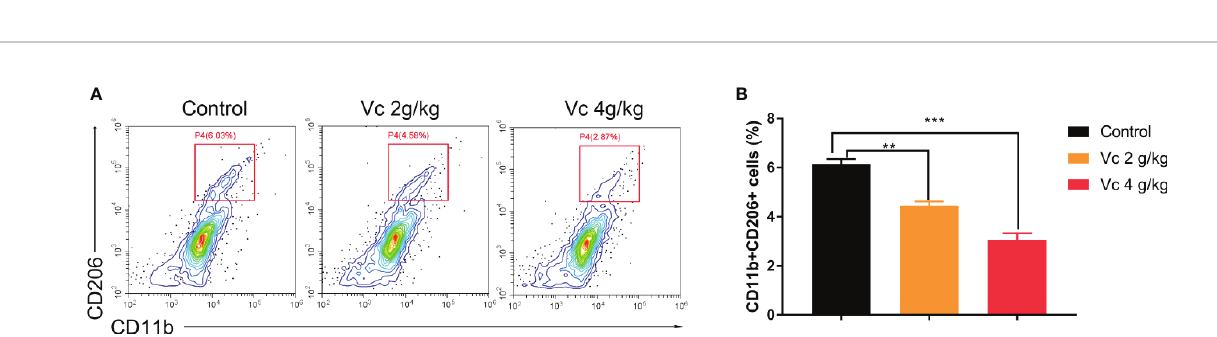
FIGURE 4 | Vitamin C inhibits epithelial-mesenchymal transition (EMT) of ovarian cancer cells in ID8 tumor nodules. (A) Western blot analysis of vimentin and E- cadherin in ID8 tumor nodules from ID8 tumor-bearing mice and ID8 tumor-bearing mice treated with vitamin C. (B, C) The quantitation of vimentin and E-cadherin levels in different ID8 tumor nodules by using ImageJ software. Data are mean ± SEM; n = 3. *p < 0.05, ***p < 0.001.